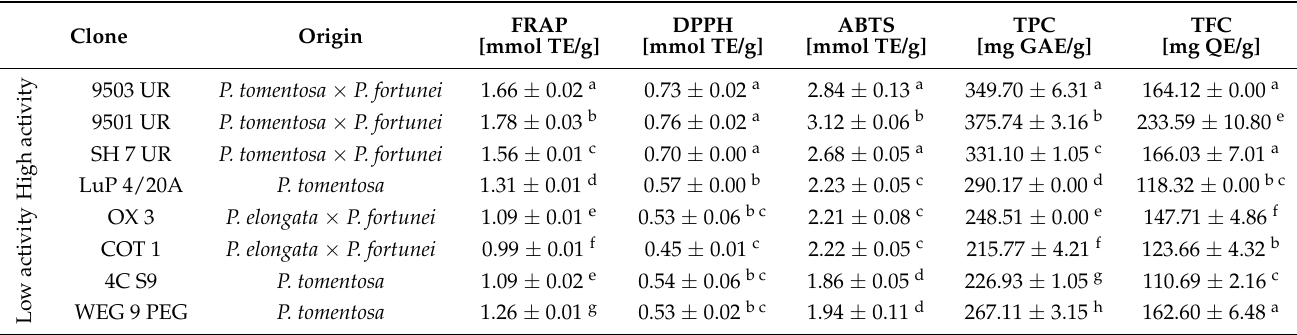
Table 3. The antioxidant activity as well as polyphenolic and flavonoids content of freeze-dried extracts of paulownia leaf